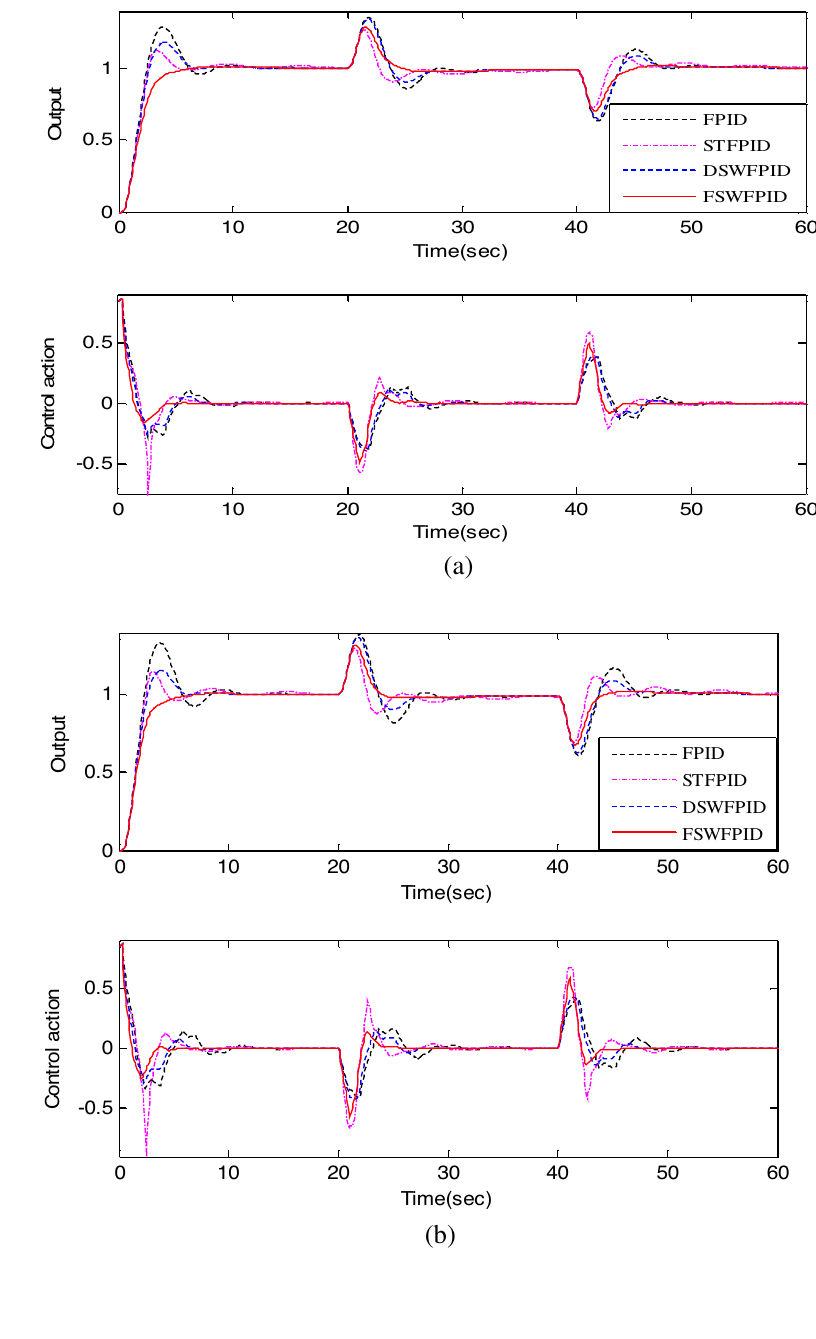
Fig. 17 Responses and control actions for Model IV using 25 rules during set point response and with load variation for a L = 0.2 s, b L = 0.3